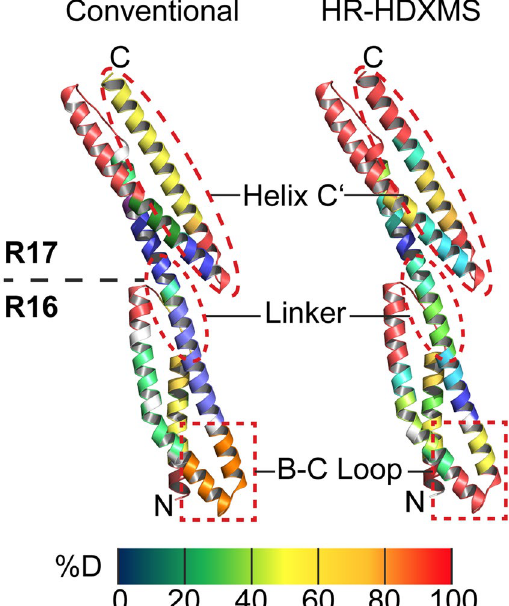
Figure 3. Improved resolution of R1617 conformational dynamics by HR-HDXMS. Deuterium uptake of R1617 mapped onto its crystal structure (PDB: 1CUN 23 ). Data analysis by HR-HDXMS ( right ) provides a superior spatial resolution of deuterium uptake compared to ‘conventional’ HDX data analysis ( left